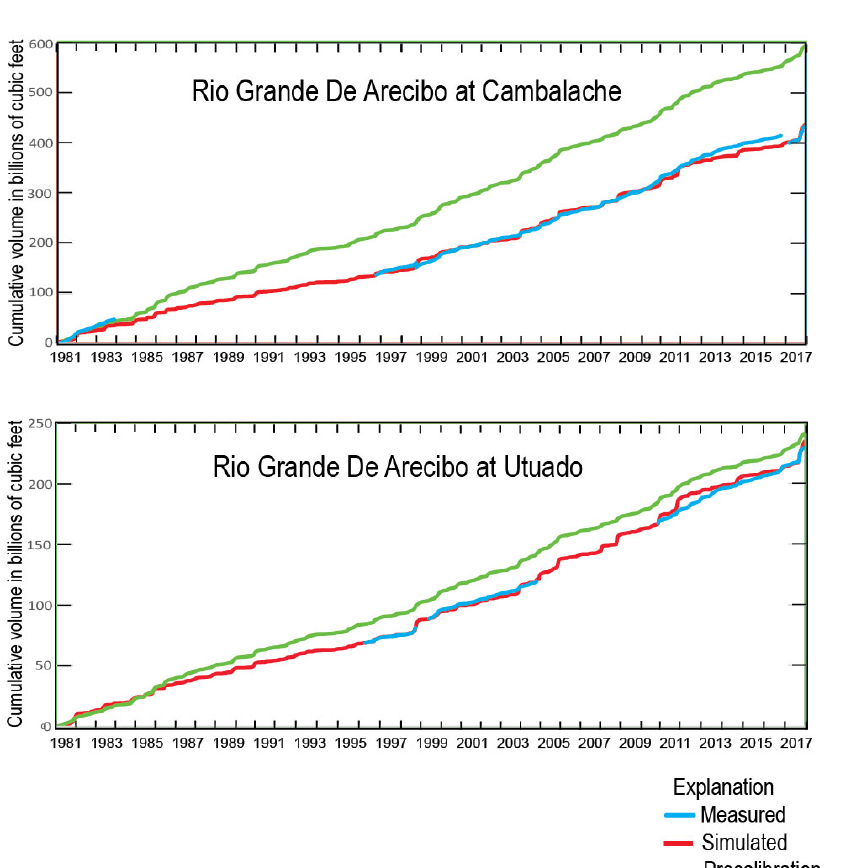
Figure 8. Cumulative flows at observation stations with manual adjustment of solar-radiation, evapotranspiration, and depression-storage parameters.